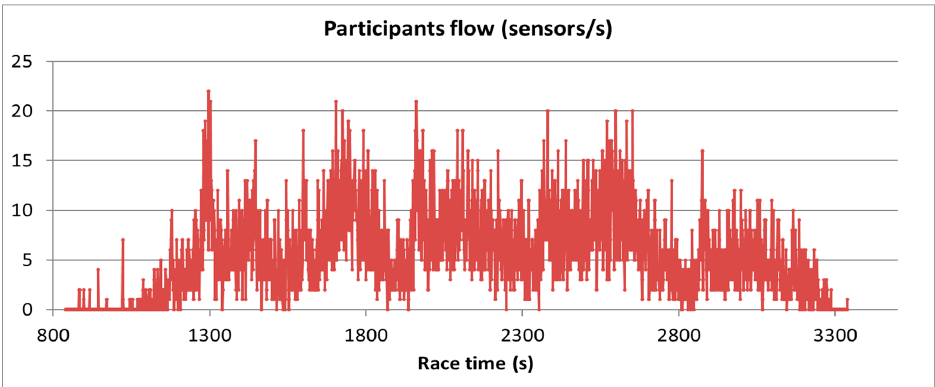
Figure 5. Sensor flow at the 5 km checkpoint.